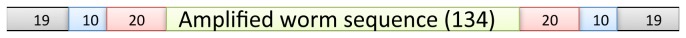
Modified primer used for PCR amplification prior to 454-pyrosequencing.Pyrosequencing fusion primers were as recommended by the manufacturer (Roche), molecular tags were as recommended by Parameswaran et al. (2007) [45] and New Zealand endemic earthworm group-specific primers were as described in Boyer et al. (2011) [15].